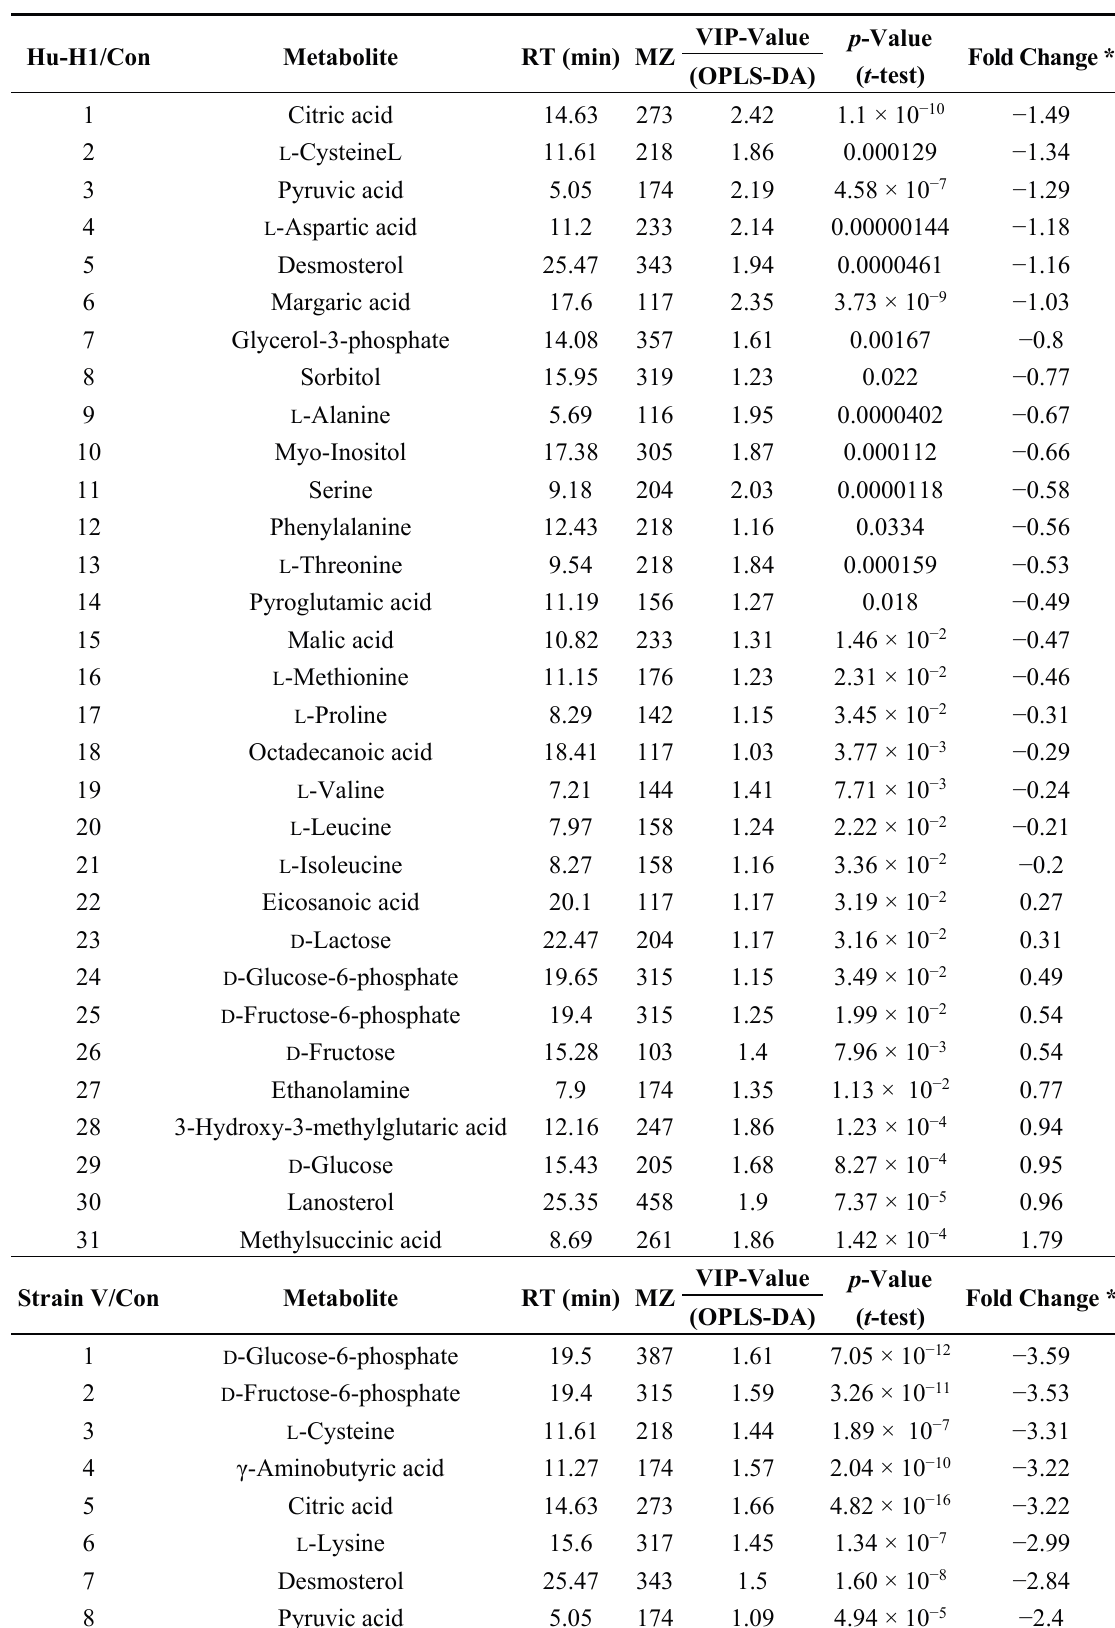
Table 2. Key differential metabolites detected by gas chromatography–mass spectrometry (GC–MS) for Hu-H1/Con and Strain V/Con.